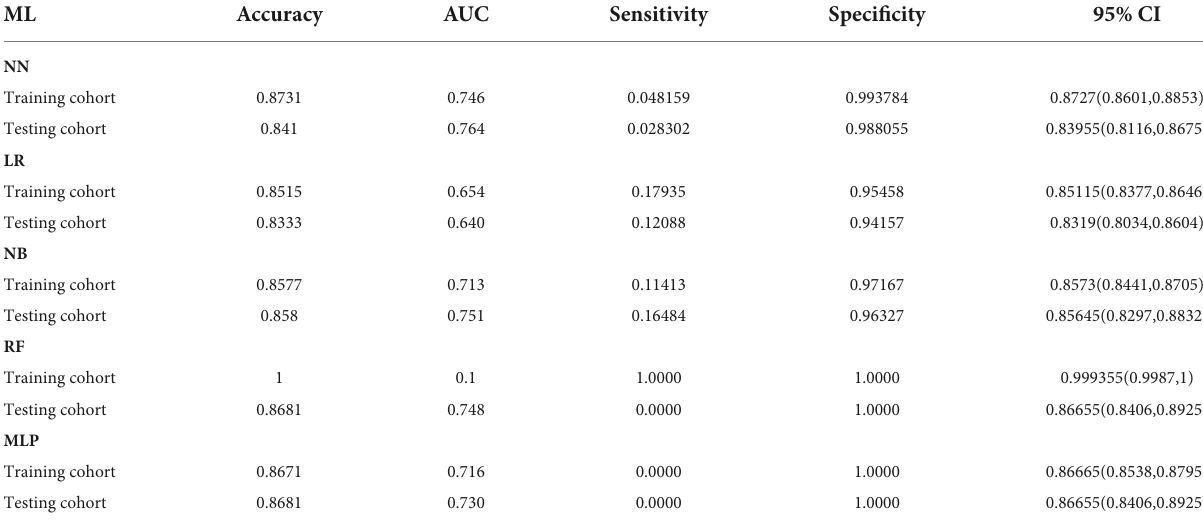
TABLE 3 Predictive performances of the five machine learning models for predicting in-hospital